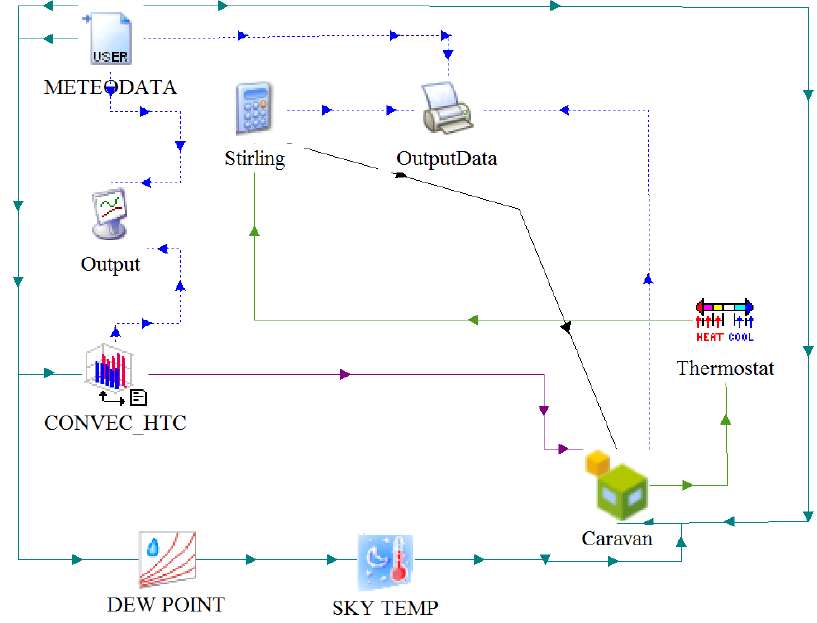
Figure 7. Layout of the TRNSYS simulation combining the three submodels.